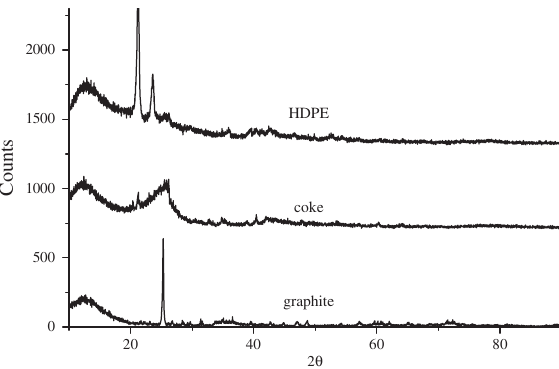
Figure 3: XRD results of various carbonaceous